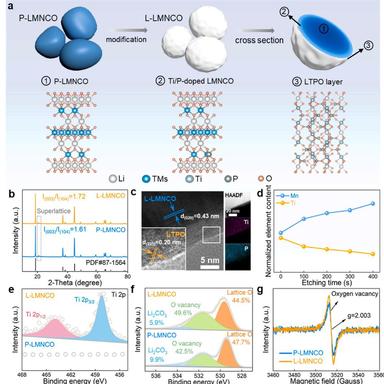
(a) Schematic illustration of the preparation procedure and the cross-sectional microstructure of L-LMNCO material; (b) XRD patterns of P-LMNCO and L-LMNCO materials; (c) HRTEM and element mapping images of L-LMNCO; (d) Mn and Ti content changes with increasing Ar-etching time; (e,f) XPS spectra of Ti and O elements in P-LMNCO and L-LMNCO; (g) EPR spectra of P-LMNCO and L-LMNCO.